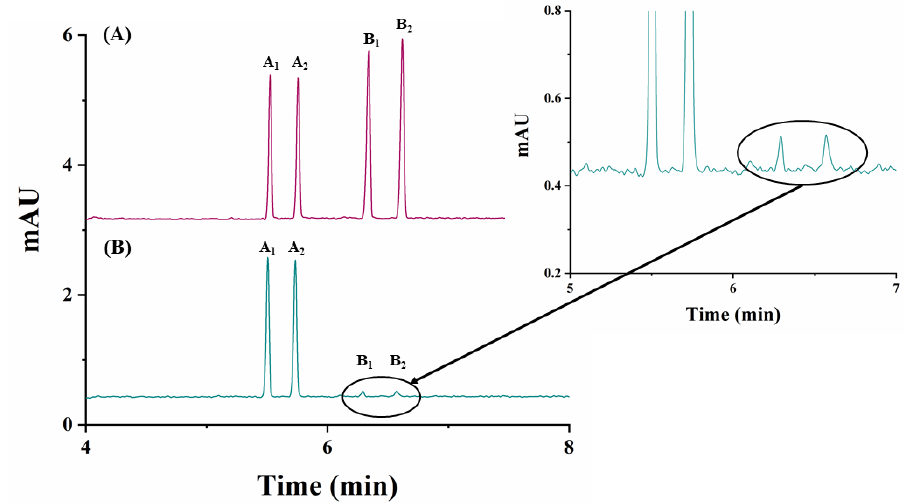
Figure 4. Electropherograms corresponding to the analysis of a carfentrazone-ethyl-based commercial agrochemical formulation using 25 mM sodium acetate buffer (pH 5.0)/2.5% ( w/v ) captisol, 30 °C and −30 kV. ( A ) Standard solution containing 30 mg L −1 of carfentrazone-ethyl racemate and 20 mg L −1 of carfentrazone racemate; ( B ) commercial herbicide formulation containing 30 mg L −1 of carfentrazone-ethyl racemate according to the label. Other experimental conditions as in Figure 2. A 1 and A 2 : carfentrazone-ethyl enantiomers. B 1 and B 2 : carfentrazone enantiomers.